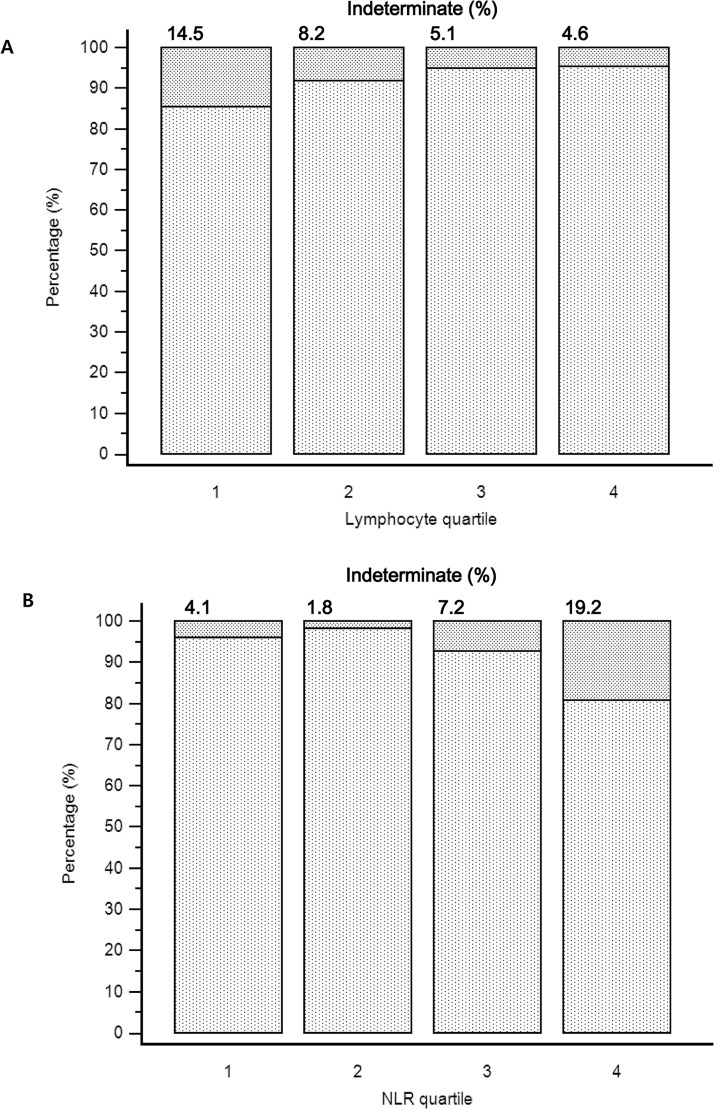
Proportions of indeterminate QuantiFERON-TB Gold In-Tube assays (n = 2773) (A) Lymphocyte quartiles (per μL).Q1;≤1050 Q2;1051–1510 Q3;1511–2093 Q4;≥2094. (B) neutrophil-to-lymphocyte ratio (NLR) quartiles. Q1;≤1.7 Q2;1.71–2.84 Q3;2.85–5.17 Q4;≥5.18.